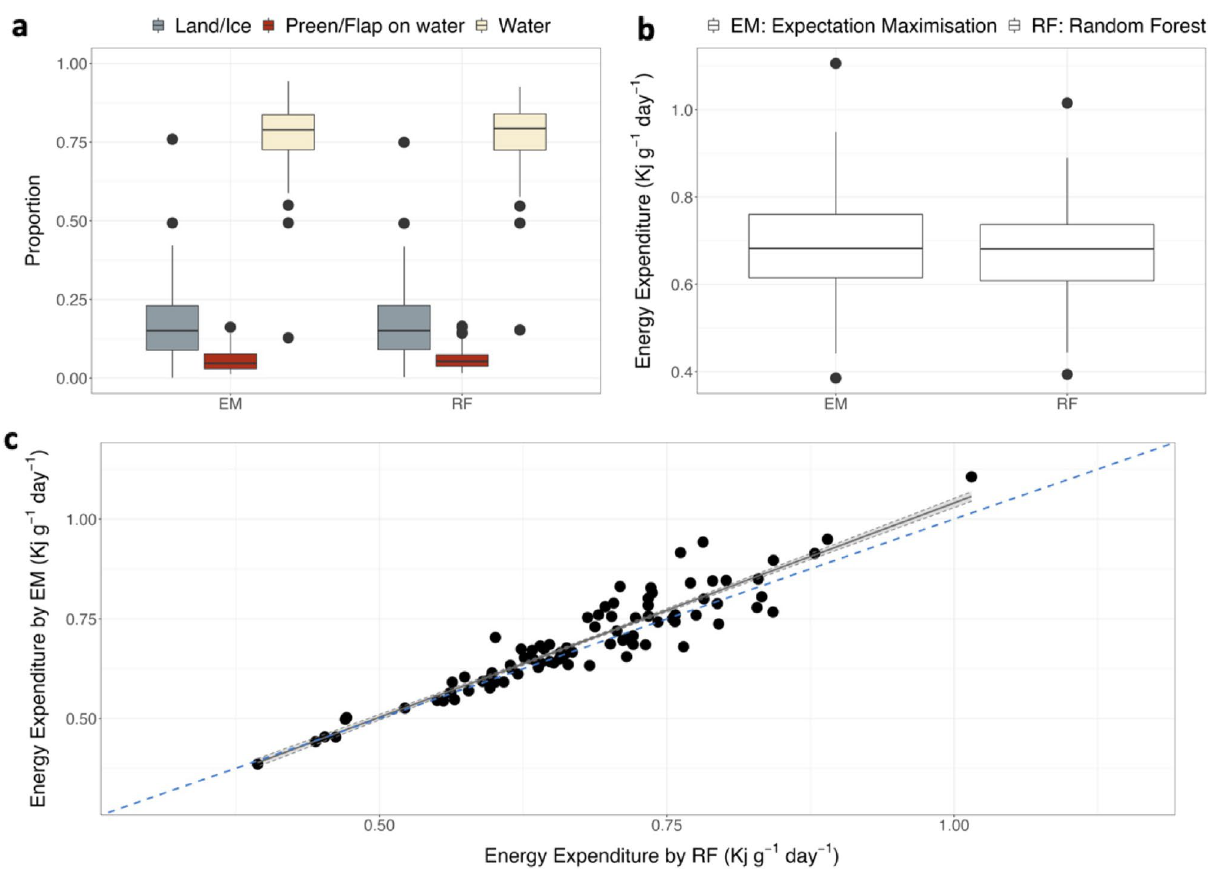
Figure 6. Daily Energy Expenditure estimated using results from two machine learning approaches. Energy Expenditure obtained accounting for the activity budgets predicted by unsupervised machine learning algorithm Expectation Maximisation (EM) and the supervised machine learning algorithm Random Forest (RF) for Adélie penguin ( Pygoscelis adeliae). ( a ) activity budgets used for calculating energy expenditure as in Hicks et al. 2020 , ( b ) boxplots of the distributions of the resulting Energy Expenditure, ( c ) comparison and regression between the Energy Expenditure calculated with the two